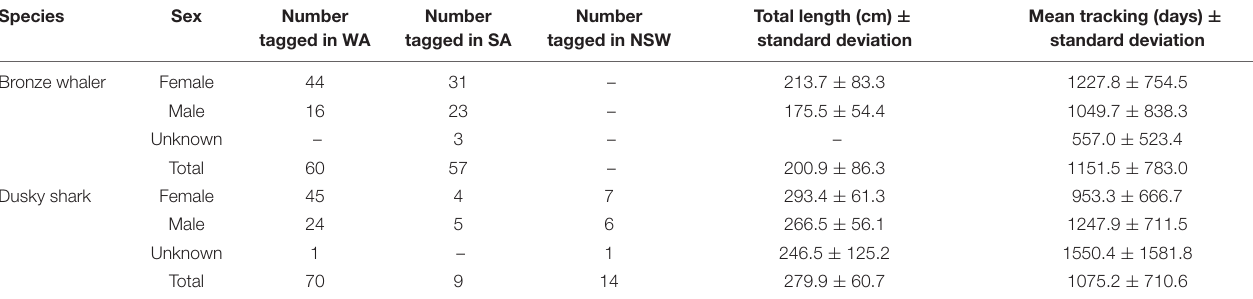
TABLE 1 | Summary of bronze whalers and dusky sharks tagged in Western Australia (WA) and South Australia (SA), and monitored throughout southern Australia. Species